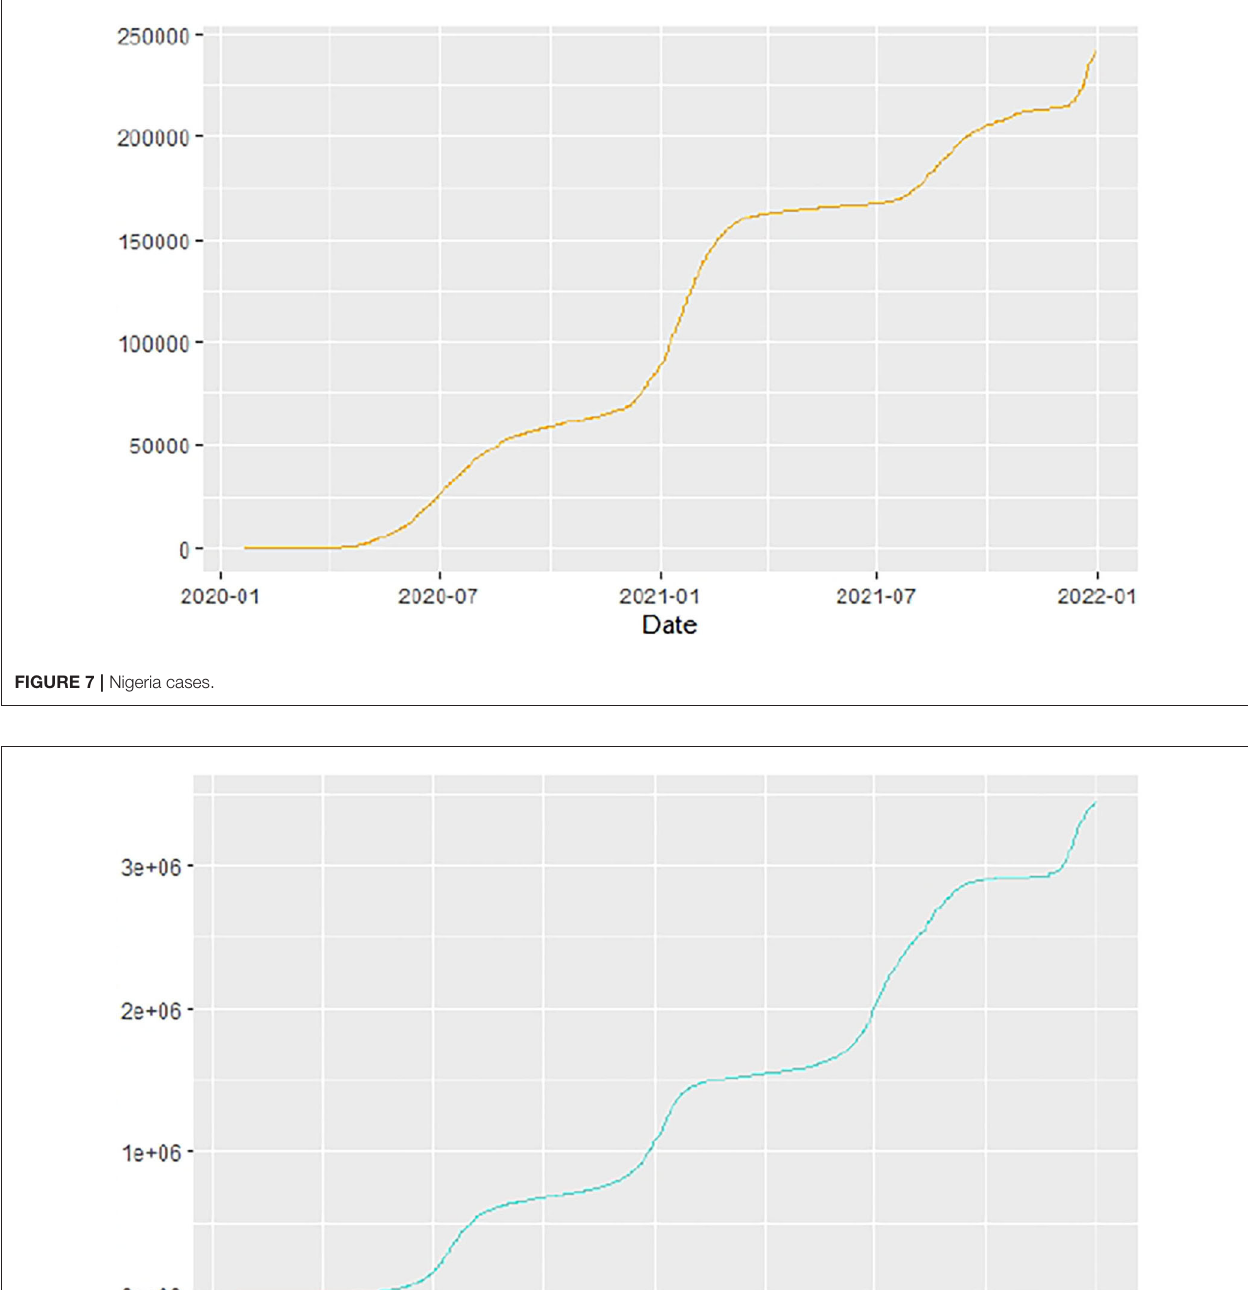
thresholds were not far from each other ( Table 2 ). In 6 of the 8 countries, we found that the herd immunity threshold is less than 0.23, and in the other 2 countries, it was between 0.23 and